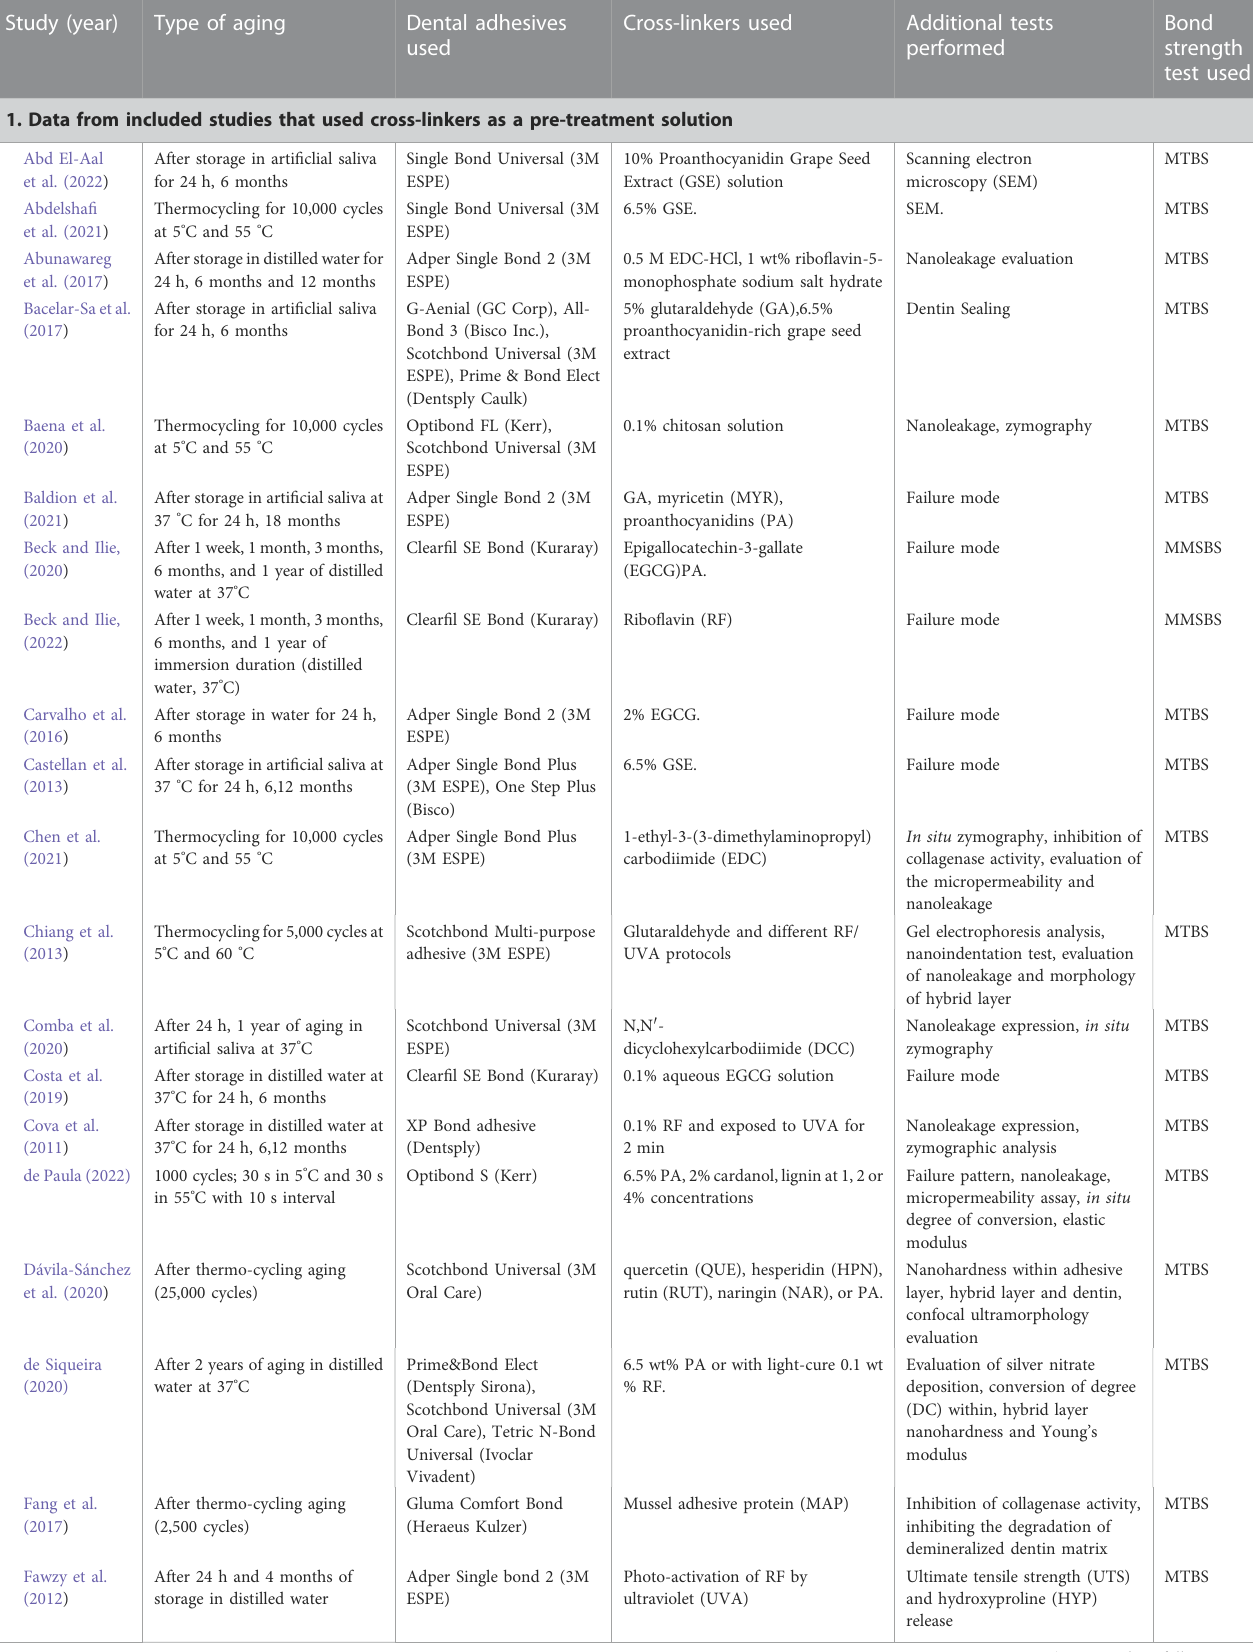
TABLE 1 Main characteristics of the in vitro studies included in the